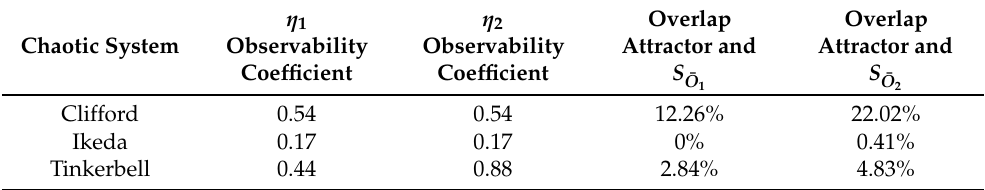
Table 3. Observability coefficients per state variable and chatic system analyzed.